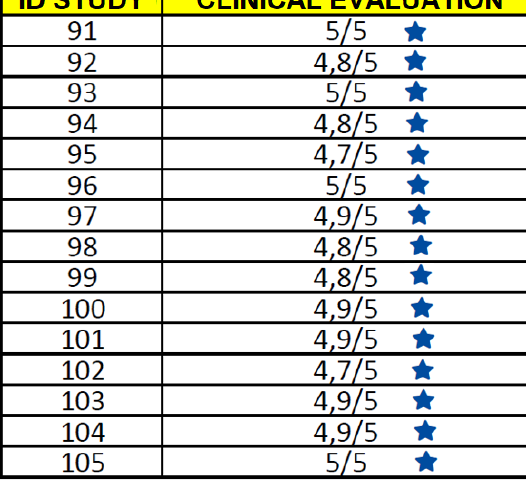
Figure 19. Average of the clinical evaluations (e.g., in terms of stars) on the slices of the CT sequence of each